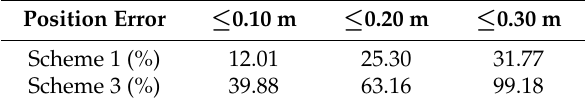
Table 5. Statistical analysis of the vertical position error probability.